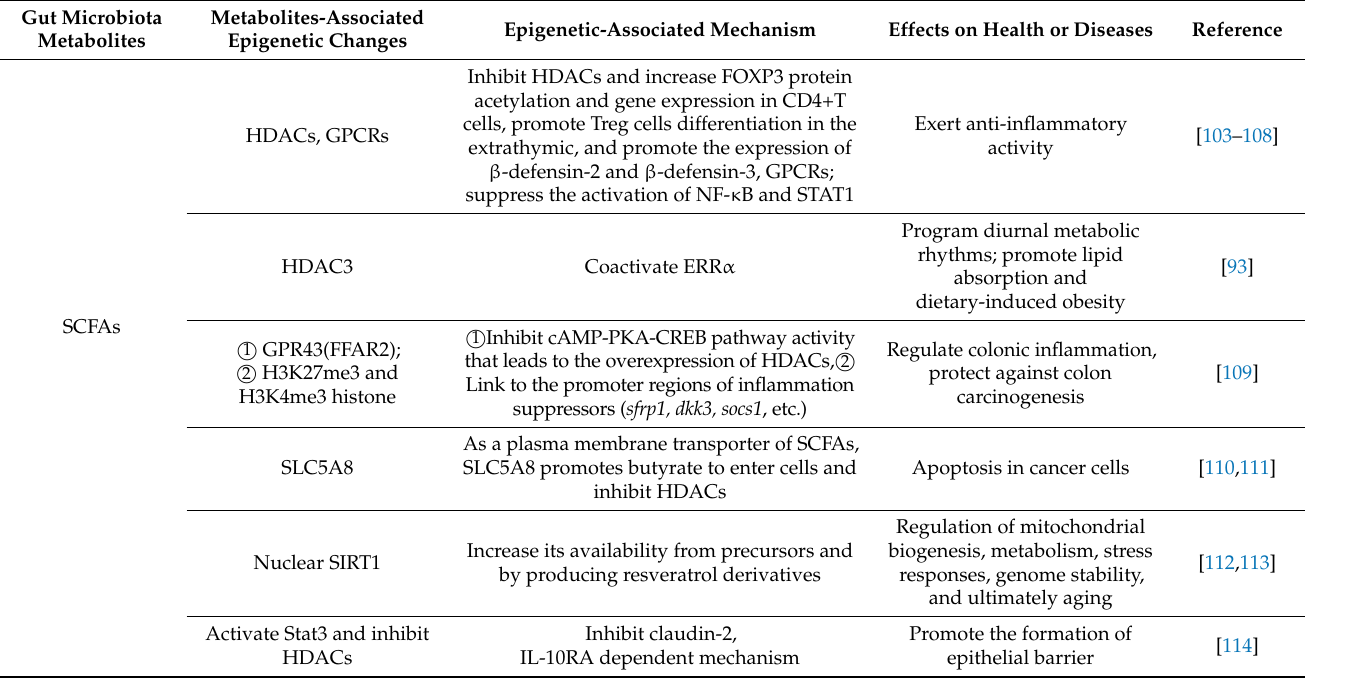
Table 3. Mechanisms of metabolites derived by gut microbiota to mediate host epigenetic changes. Gut Microbiota